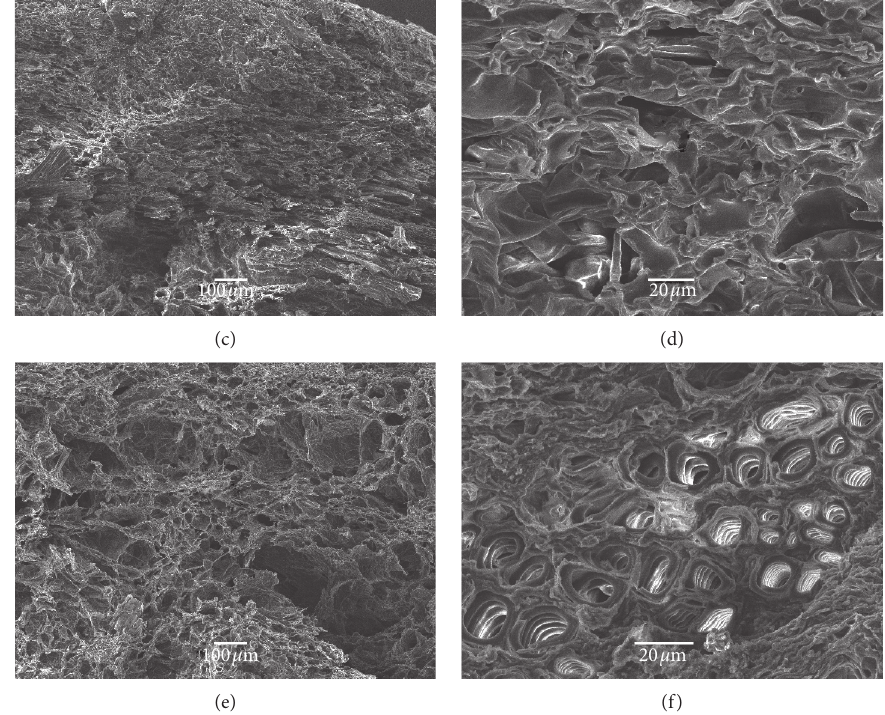
Figure 4: Scanning electron microscopy of raw (a b, c, and d) and washed (e and f) Tunisian PGP (El Gabsi).